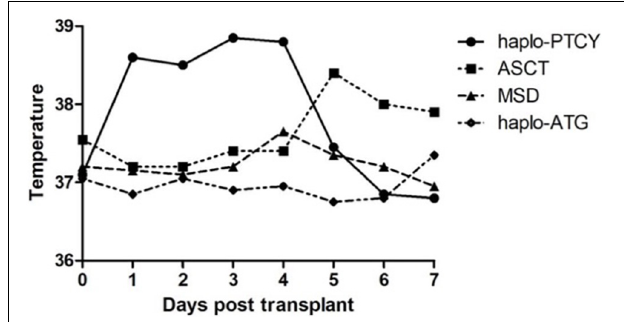
FIGURE 1 | The temperature profile of patients undergoing hematopoietic stem cell transplantation (HSCT) of various types from June 2019 to December 2020 [haplo-post-transplantation cyclophosphamide (haplo-PTCY) n = 37; macthed sibling donor (MSD) n = 20; autologous stem cell transplant (ASCT) n = 18; haplo-anti-thymoglobulin n = 4].